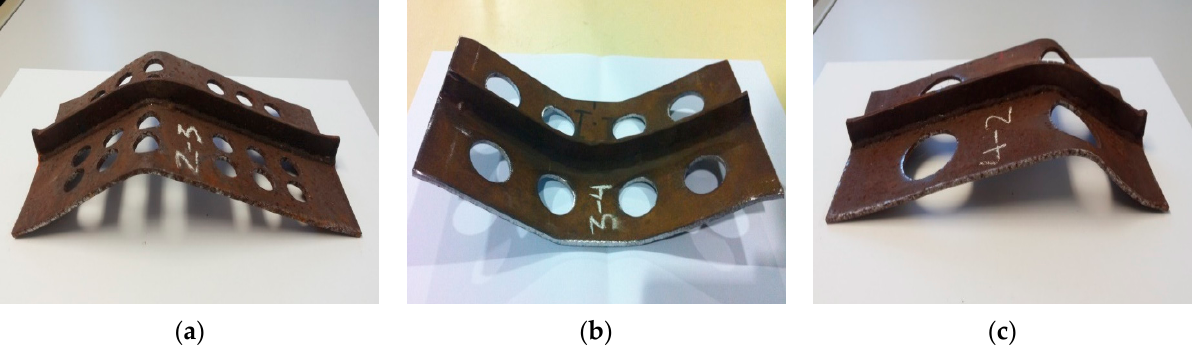
Figure 6. Post-collapse deformed shape, DoO = 16.80%, SP-NS2-3 ( a ), SP-NS3-4 ( b ) and SP-NS4-2 ( c